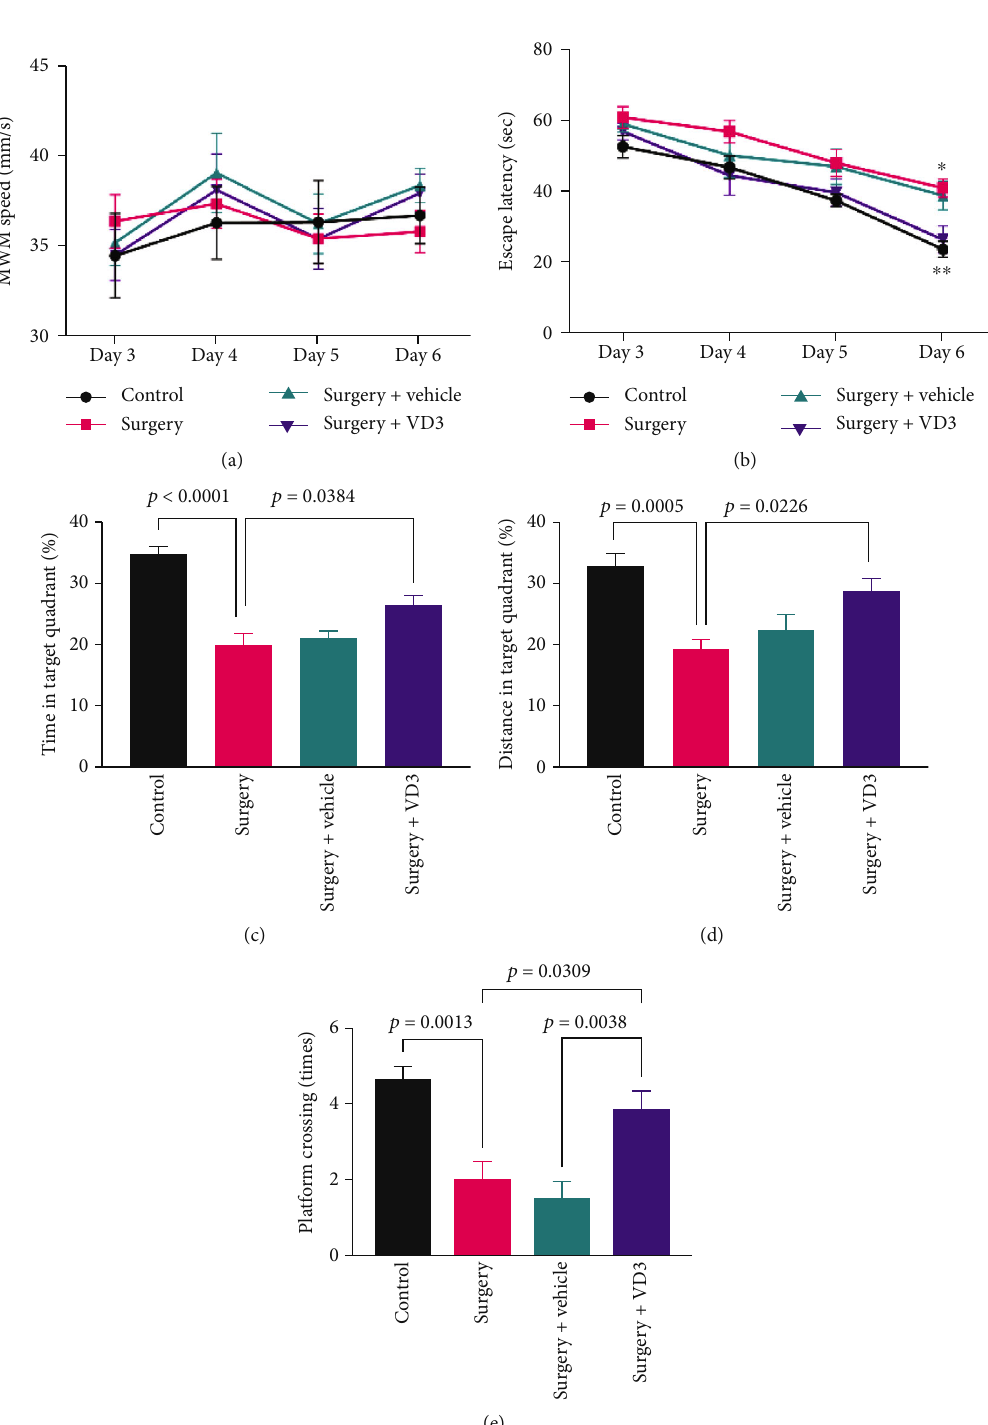
Figure 2: The e ff ect of VD3 on surgery-induced postoperative cognitive impairment in aged mice. (a) Swimming speed of mice in the MWM test. (b) Escape latency in the MWM test. (c, d) Time and distance in the target quadrant. (e) Numbers of platform crossing. Data are presented as mean ± SD ( n = 8 per